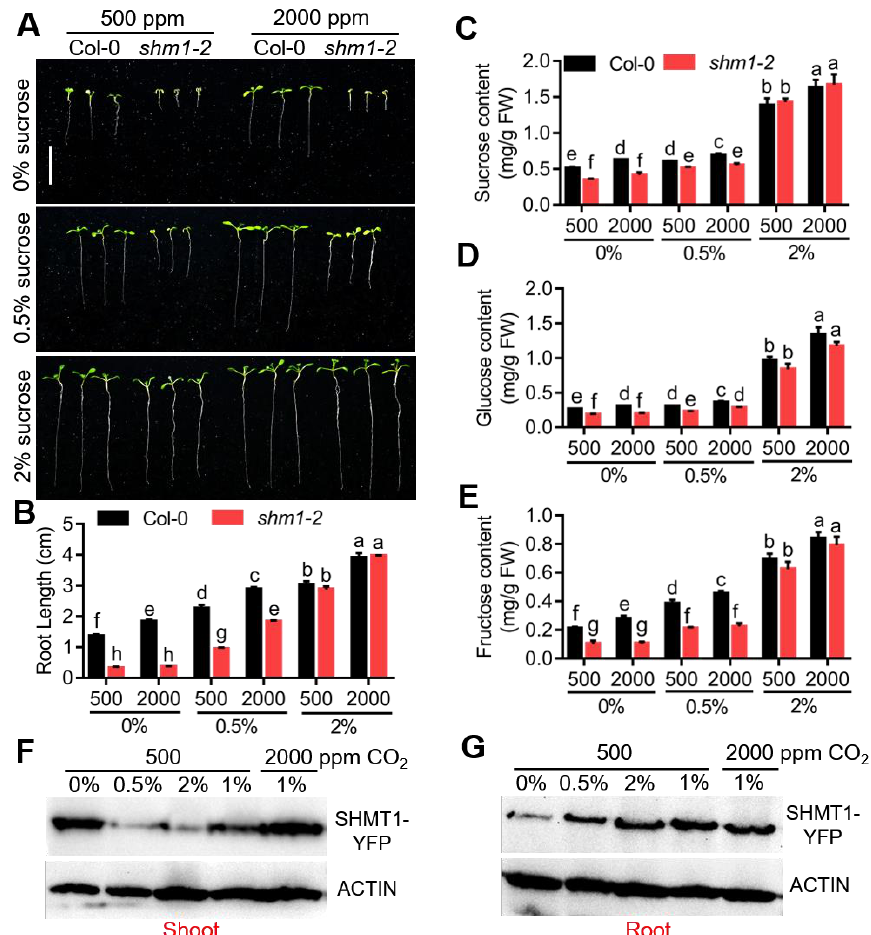
Figure 3. Elevated CO 2 alone did not recover the growth-retardation phenotype of shm1-2 at sucrose- free conditions. ( A ) The root-growth phenotype of shm1-2 and Col-0 grown on 1/2 MS medium containing different concentrations of sucrose at 500 or 2000 ppm CO 2 for 8 days. ( B ) The root length was statistically analyzed as shown in ( A ). Data presented were means ± SEM, n = 3 experiments, each with 10 roots per genotype. Bars = 1.5 cm. ( C – E ) The contents of sucrose ( C ), glucose ( D ), and fructose ( E ) in shm1-2 and Col-0 seedlings grown on 1/2 MS medium containing 0%, 0.5%, or 2% sucrose at 500 or 2000 ppm CO 2 for 8 days. Data presented were means ± SEM, n = 3 experiments. Different letters above error bars indicated significant difference at p < 0.05, using two-way ANOVA with Tukey’s test. Western blot analyses of SHMT1 protein levels in shoots ( F ) and roots ( G ) of 35S- SHMT1-YFP expressing transgenic plants grown on 1/2 MS medium containing 0%, 0.5%, 2% sucrose at 500 ppm CO 2 or 1% sucrose at 500, 2000 ppm CO 2 for 8 days. Actin was used as a loading control.